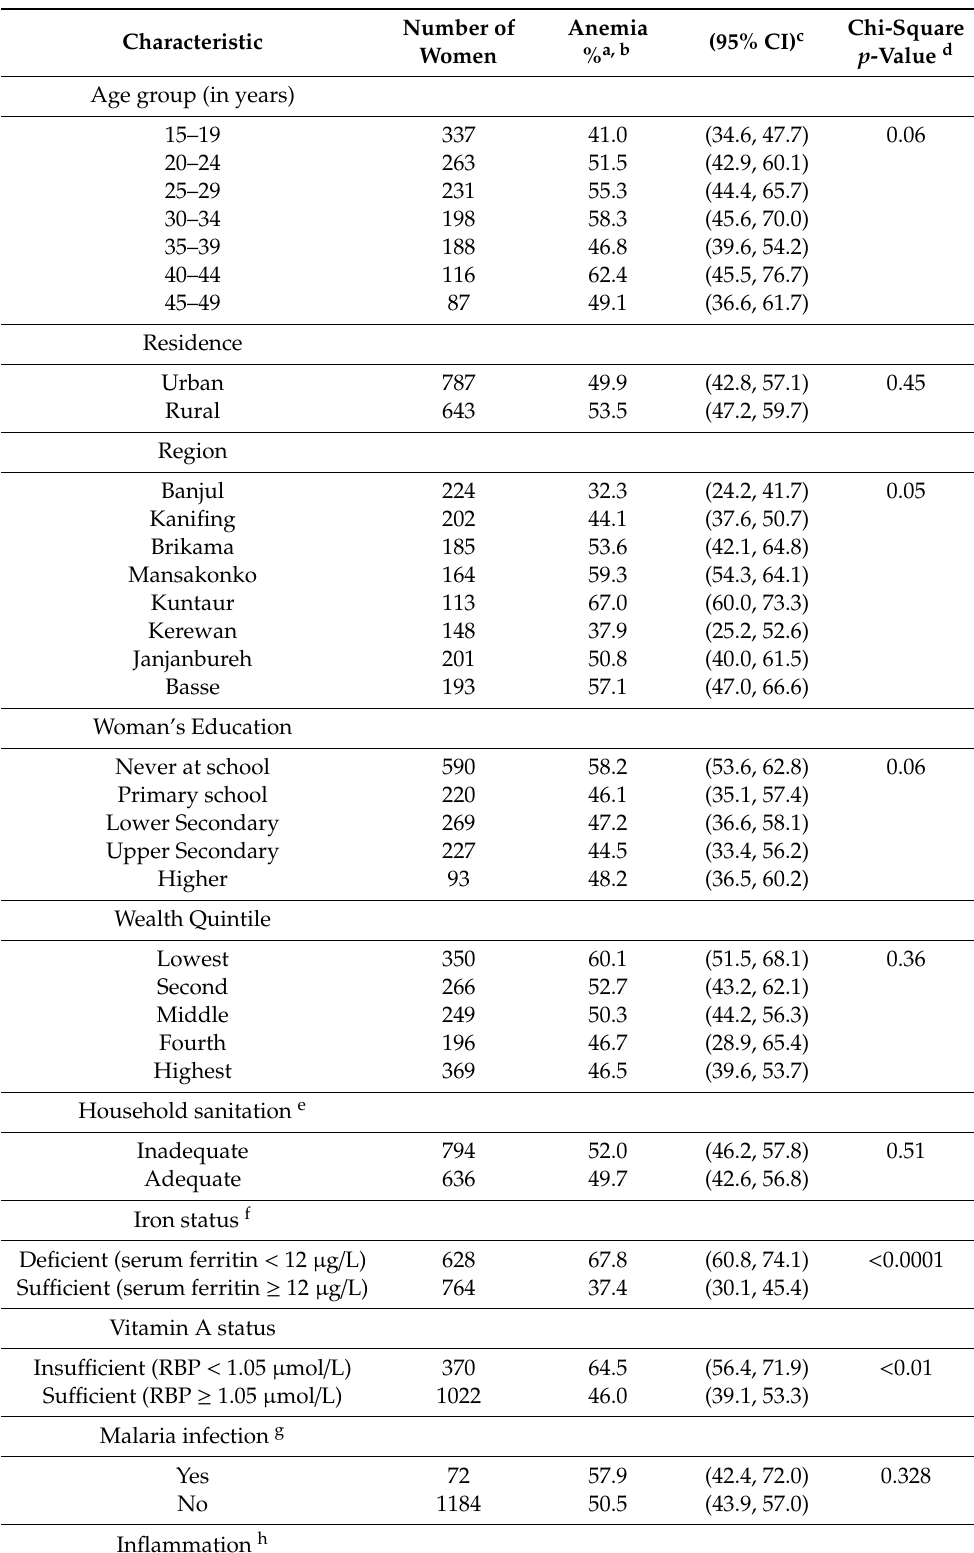
Table 5. Bivariate associations between anemia in non-pregnant women and demographics, nutritional status indicators and disease, The Gambia